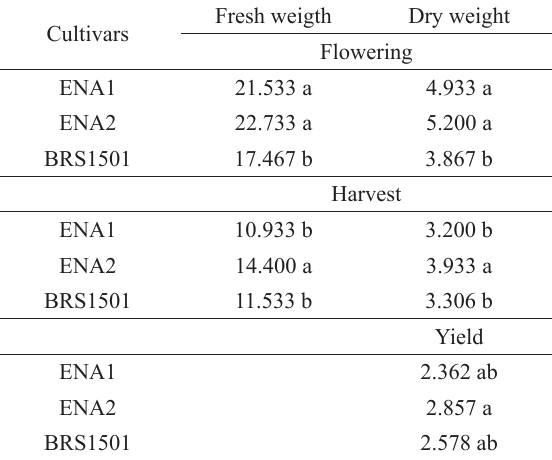
Shoot fresh and dry weights at flowering and maturation (kg ha -1 ) and final grain yield (kg ha -1 ) of three pearl millet cultivars.